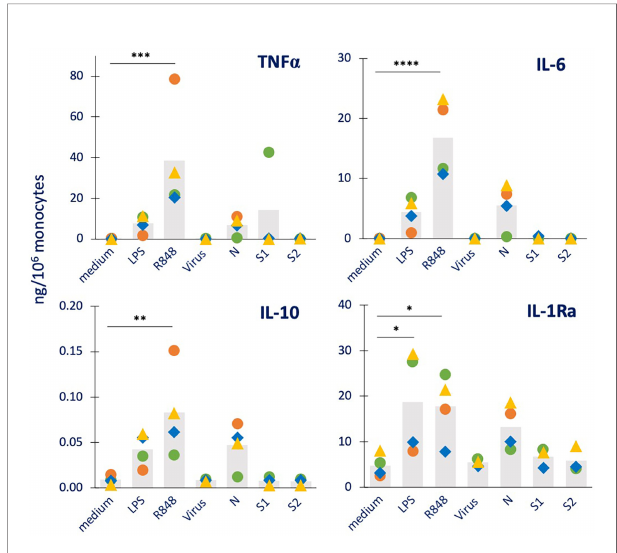
FIGURE 1 | Primary innate immune primary response to inactivated SARS- CoV-2 or its proteins in human monocytes. Human monocytes isolated from blood of four individual donors (green, red, blue, and yellow symbols) were cultured for 24 h in culture medium alone or containing the inactivated SARS- CoV-2 virus (5 x10 5 copies), or the viral proteins N, S1, S2 (all at 1 µg/mL). The production of TNF a (upper left), IL-6 (upper right), IL-10 (lower left) and IL-1Ra (lower right) was measured in the 24 h supernatants by ELISA. Medium alone was used as baseline value, LPS (1 ng/mL) and R848 (0.5 µg/ mL) were used as positive controls. Data are presented as individual donors ’ values (colored symbols) and as mean of the individual values (gray columns). Statistical signi fi cance: * p < 0.05; ** p < 0.01; *** p < 0.01; **** p <